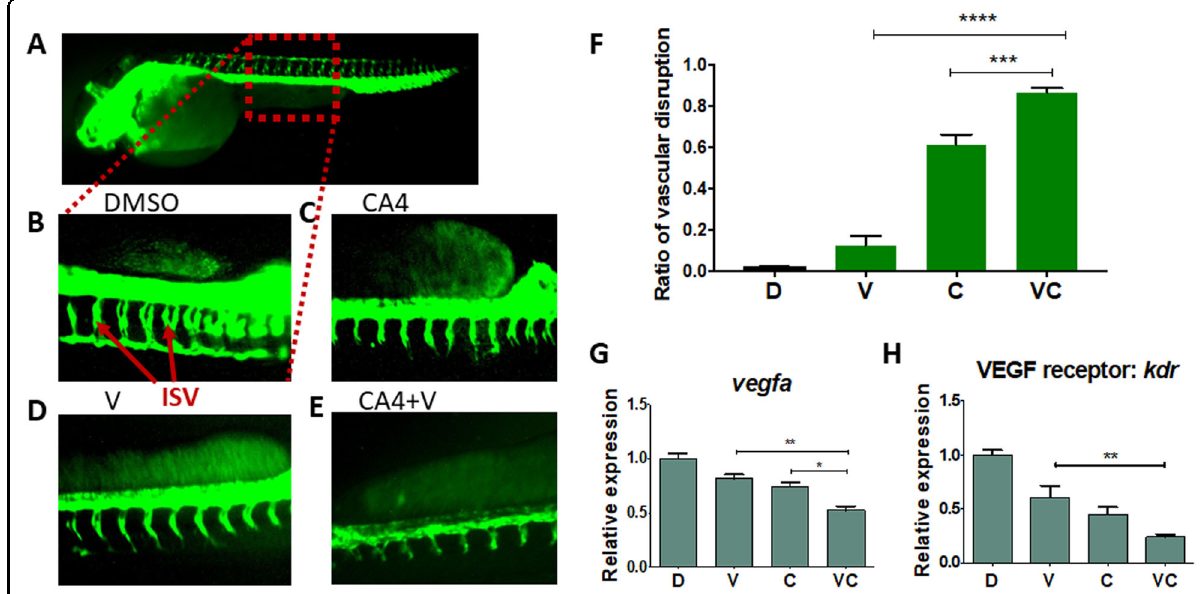
Fig. 3 Vertepor fi n in combination with combretastatin more effectively inhibits vasculature in transgenic zebra fi sh (Tg, fl i:eGFP) embryos. The zebra fi sh embryos at 8-hrs post fertilization were treated with drugs for 48 hrs. A Healthy zebra fi sh embryo taken at 8× magni fi cation. Intersegmental vessel (ISV) phenotypes in a sectional view of: B DMSO; C CA4, 5 nM; D V, vertepor fi n, 250 nM; E V + CA4. F Graphical summary showing the ISV disruption ratio of B – E. Data are expressed as mean ± SEM, n = 5 embryos. G , H RT-qPCR analysis of vascular endothelial growth factor A ( VEGFA , an angiogenesis gene) and VEGF receptor kdr in zebra fi sh embryos after treatments. Data are expressed as mean ± SEM, n = 4 embryos. * P < 0.05, ** P < 0.01, **** P <